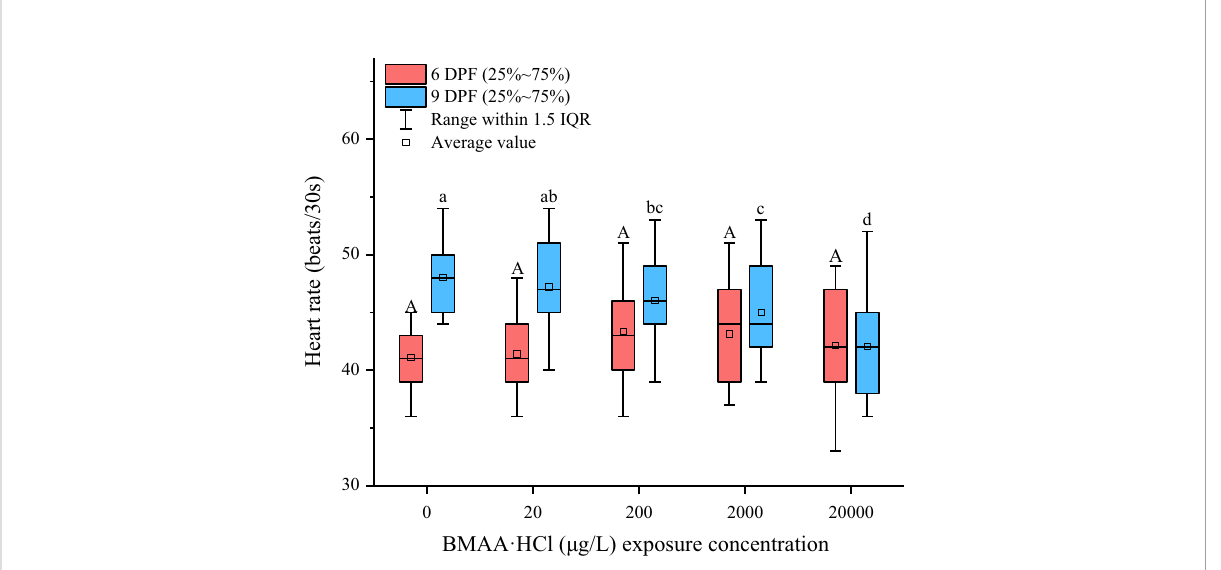
FIGURE 4 Heart rates measured at 6 days post fertilization (DPF) and 9 DPF in marine medaka ( Oryzias melastigma ) embryos exposed to BMAA. Note: An equivalent volume of 2 mM HCl used in the highest BMAA exposure treatments was added into the culture wells as solvent control group and labeled as a zero concentration of BMAA. The different letters indicate a signi fi cantly different result between treatments ( p < 0.05).